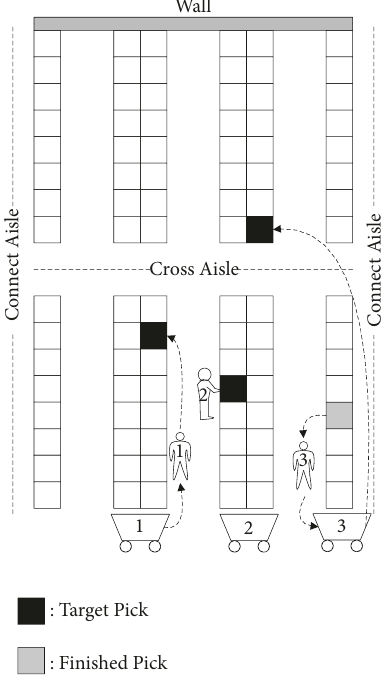
Figure 1: Order picking in the ultranarrow